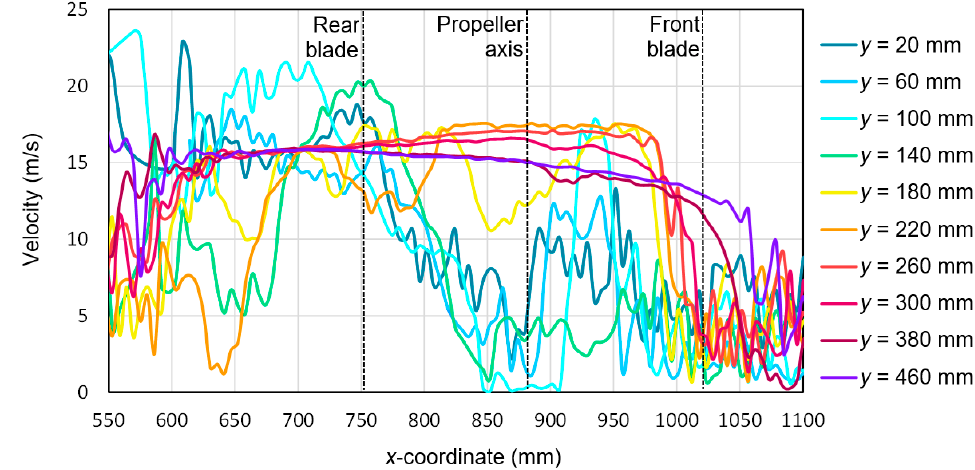
Figure 23. Resultant airflow velocities around the research object for the following configuration: angle of attack α = − 12° and airflow in the wind tunnel v wt = 12.5 m/s.